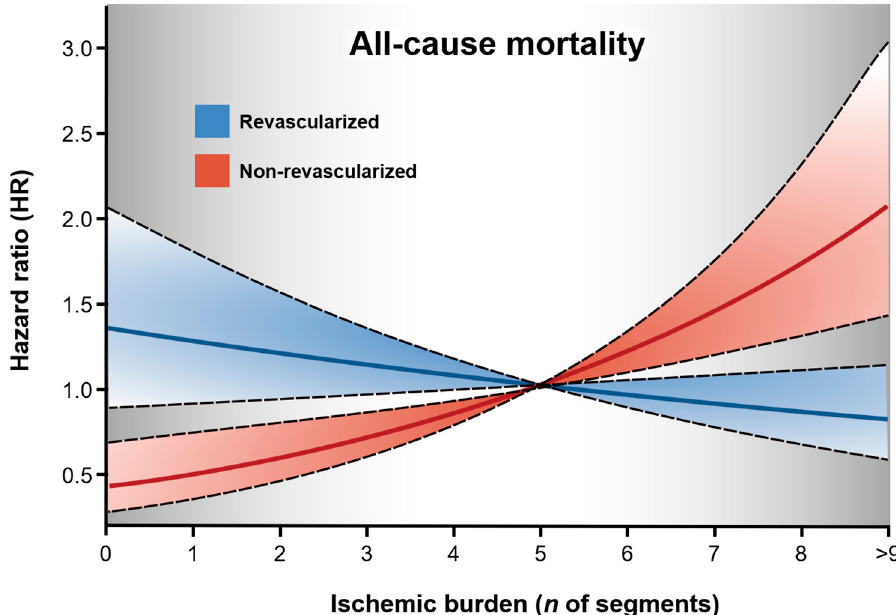
Figure 2. Effect of stress CMR-related revascularization on all-cause mortality in a large real-life registry of patients with known or suspected CCS. Adapted from Marcos-Garces et al. [62] following the STM Permissions Guidelines (2014). Results derived from a large registry of patients with known or suspected CCS undergoing stress CMR. In non-revascularized patients, the risk of all-cause mortality increased in parallel with ischemic burden (number of segments with inducible perfusion defects on stress first-pass perfusion) but the opposite trend was observed in revascularized patients, with lines crossing at five ischemic segments. Shaded areas correspond to patient profiles that were “probably” not included in the ISCHEMIA trial. Abbreviations: CCS, Chronic coronary syndrome; CMR, Cardiac magnetic resonance.